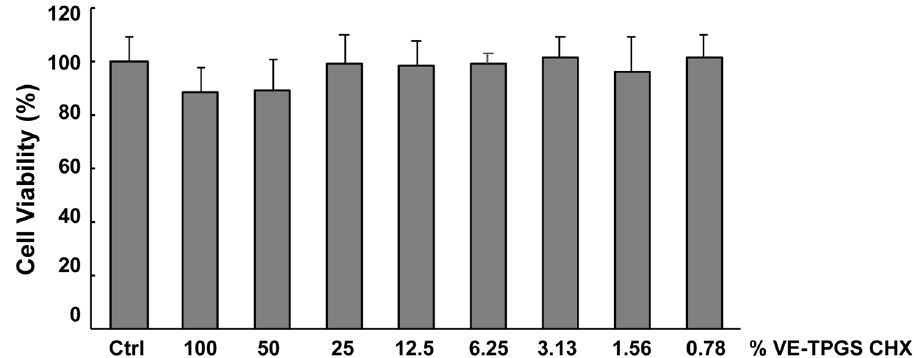
Figure 1. VE-TPGS CHX formulation is not cytotoxic. The formulation of VE-TPGS (0.5% w/w ) and CHX (0.02% w/w ) was tested on L929 cells by MTT assay. Cells were incubated for 24 h with the formulation (100%) or its serial dilutions. Each condition was performed in triplicate and the experiment repeated three times. The cell viability of the treated cells is expressed as percentage of the control (Ctrl). The Student's t -test shows no significant difference among all the conditions.